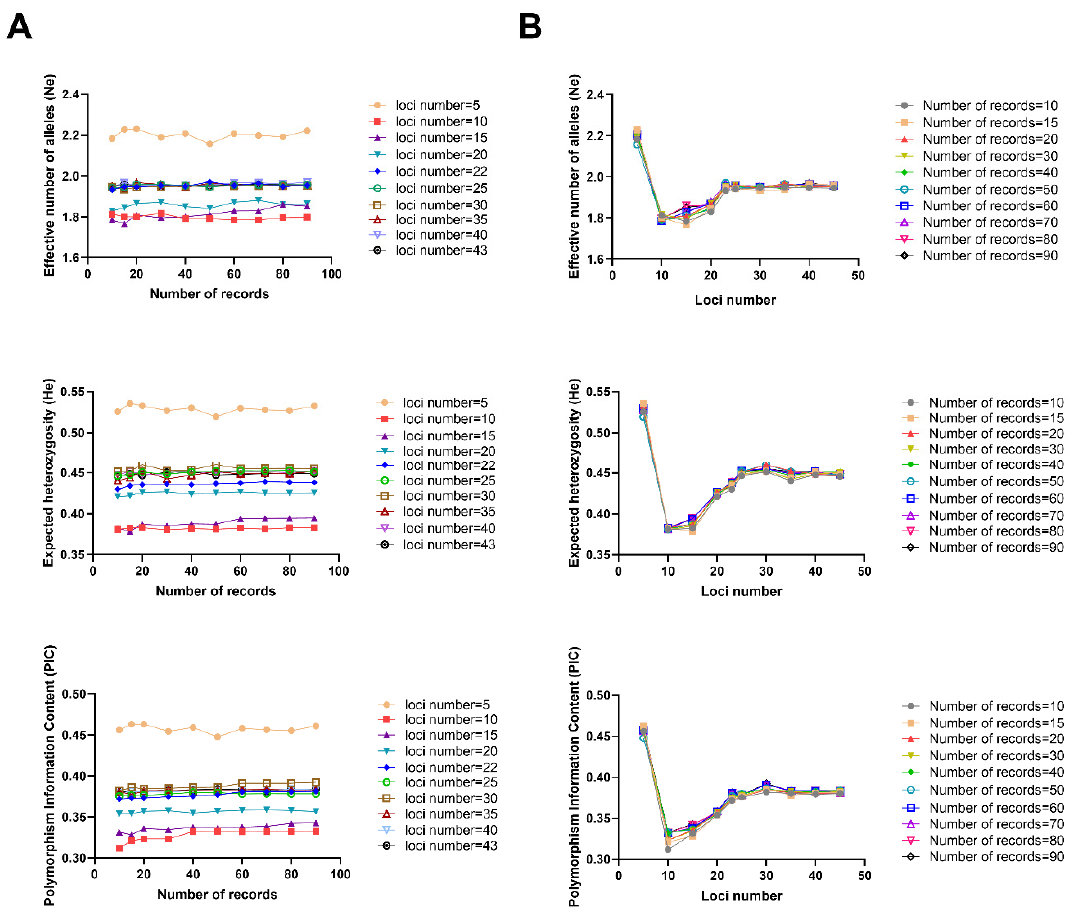
Figure 1. Statistical analysis of genetic diversity of New Zealand white rabbits under different numbers of records and loci numbers. ( A ) Changes in genetic diversity parameters with the number of records for different loci numbers for New Zealand white rabbits; ( B ) Changes in genetic diversity parameters along with loci numbers for different numbers of records for New Zealand white rabbits.